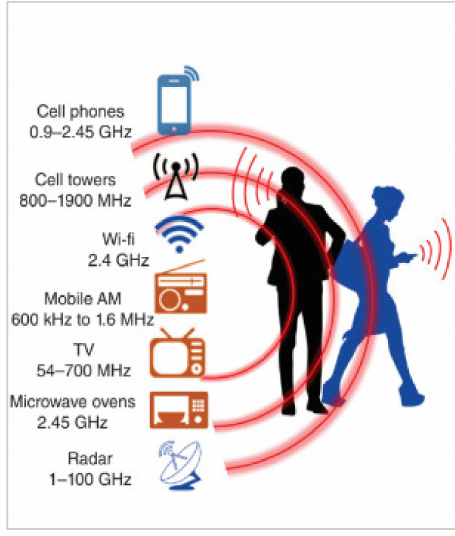
Figure 1. EM sources and effects on humans.